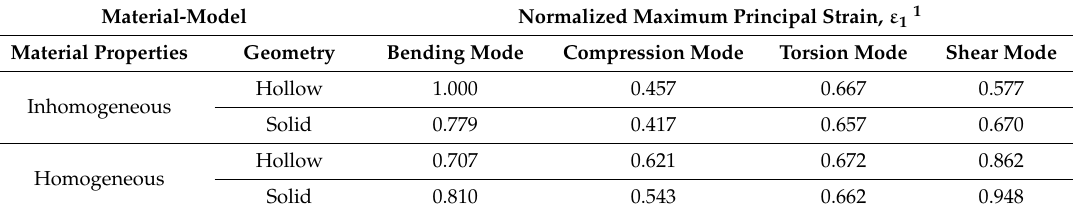
Table 3. Normalized strain